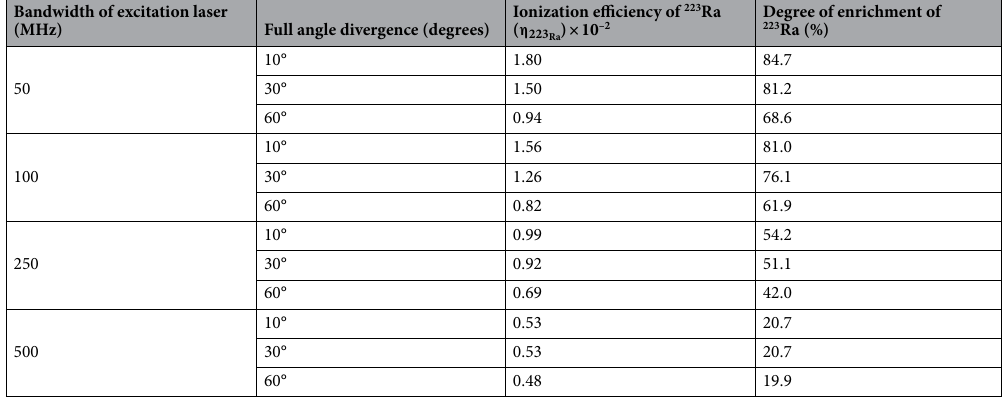
Table 4. Table of variation in the degree of enrichment of 223 Ra with the increase in the angular divergence of the atomic beam. Peak power density of the excitation and ionization lasers is 10, 10, 10,000 W/cm 2